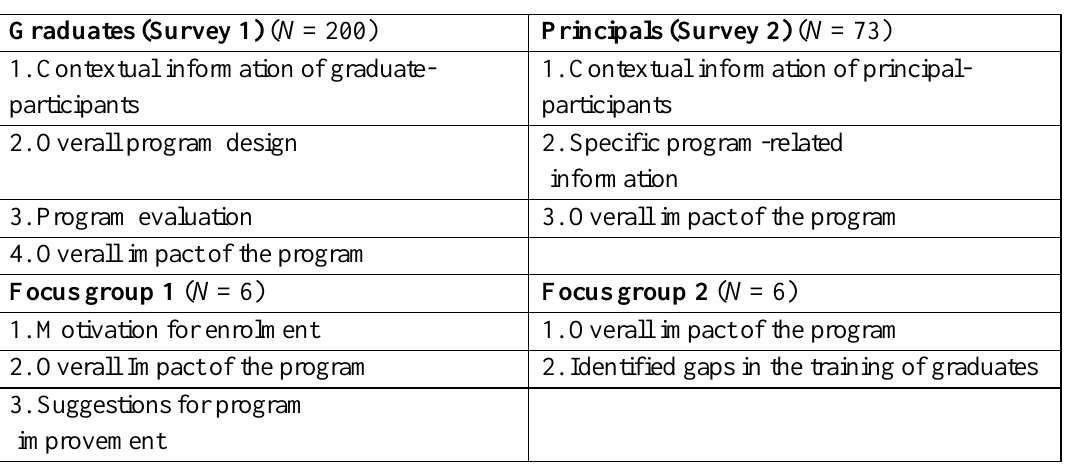
Instruments Used in the